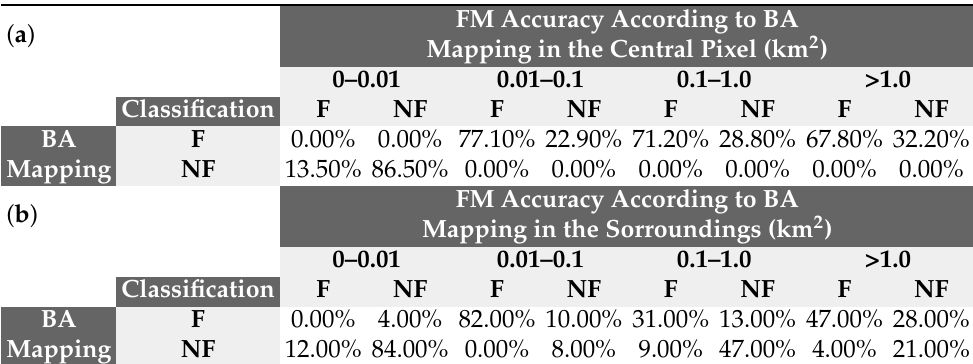
Table 2. Final model prediction accuracy considering burned areas. F: Fire; NF: Non